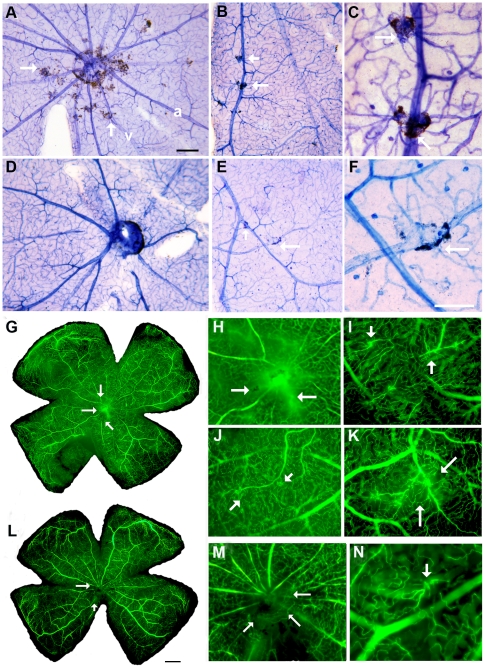
Vascular protection.A–F: Retinal whole mount was stained with NADPH-diaphorase: A. typical vascular pathology in the eye at P90 in untreated RCS rat: vascular complexes (abnormal vessels associated with RPE cells) were mainly located around the optic nerve disc (arrows) and spread peripheral with age. B. vascular complexes in the middle to peripheral retina (arrows). C. high power image showing vascular complexes (arrows) from B. D. RCS retina treated with MSCs at P90: the vascular complexes were dramatically reduced around the optic nerve disc. E. two vascular complexes (arrows) in the middle field of the retina. F. high power image from E showing vascular complexes (arrow). G–L. animal was perfused with FITC-dextran, whole mount was prepared: G. typical vascular leakage, mainly around the optic disc in untreated eye at P90. H–K. high power images from G showing vascular leakage (arrows in H) and abnormal vessels (arrows in I–K). L. MSC treated retina, the vascular leakage around the optic nerve disc was greatly reduced. M&N. high power images from L showing much reduced leakage (arrows in M) and small abnormal vessels (arrow in N) (Scale bars equal 250 µm for A, D, G &L; 100 µm for F).